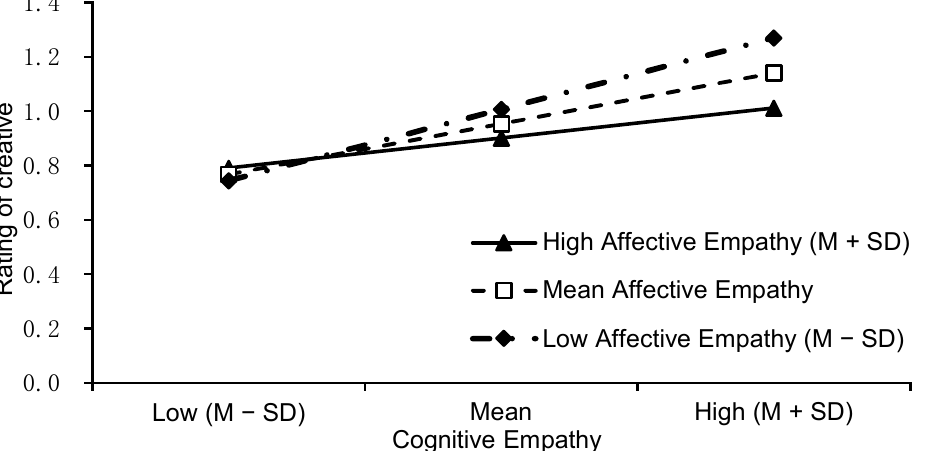
Figure 4. The simple slope of cognitive empathy in different affective empathy levels for the disad- vantaged condition.